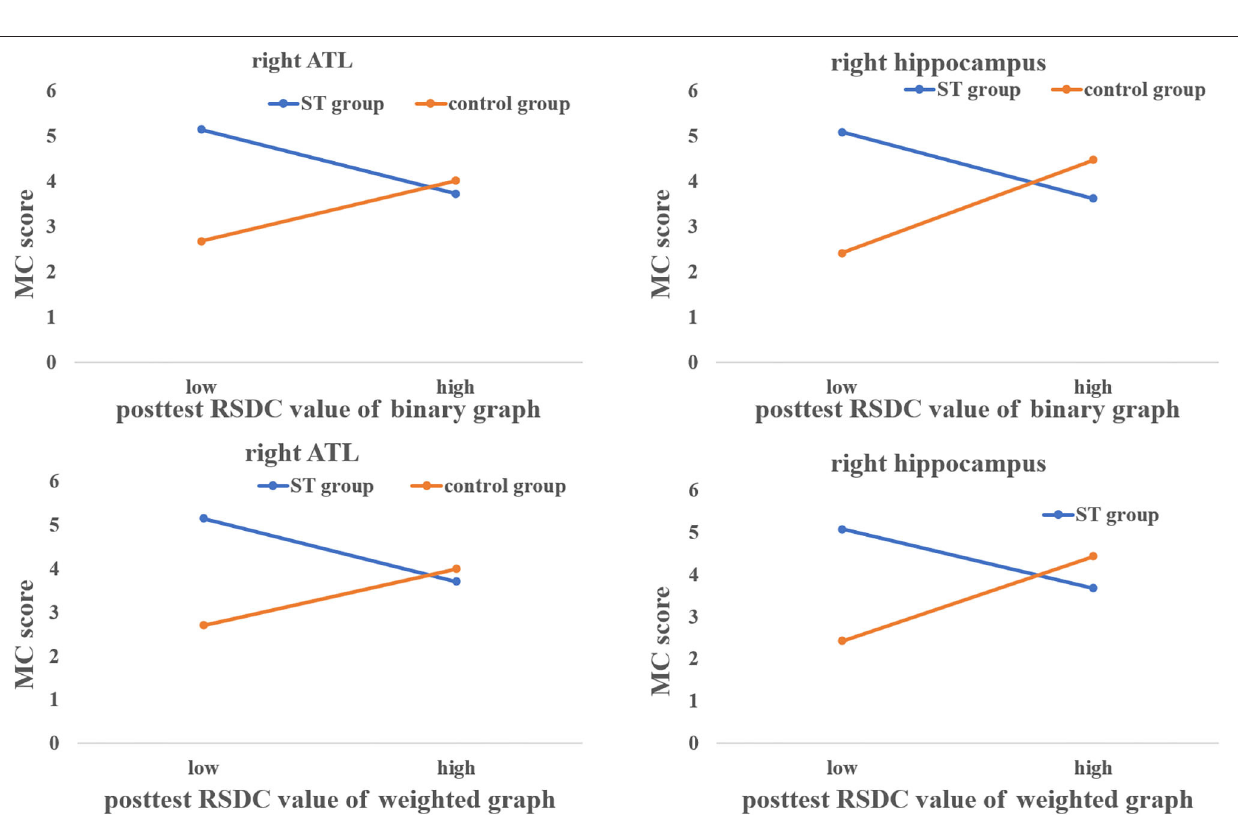
The self-relevant processes under ST could also be reflected by the increased RSDC in the PPC. Previous studies suggested that the PPC can be divided into the dorsal parietal cortex (DPC)